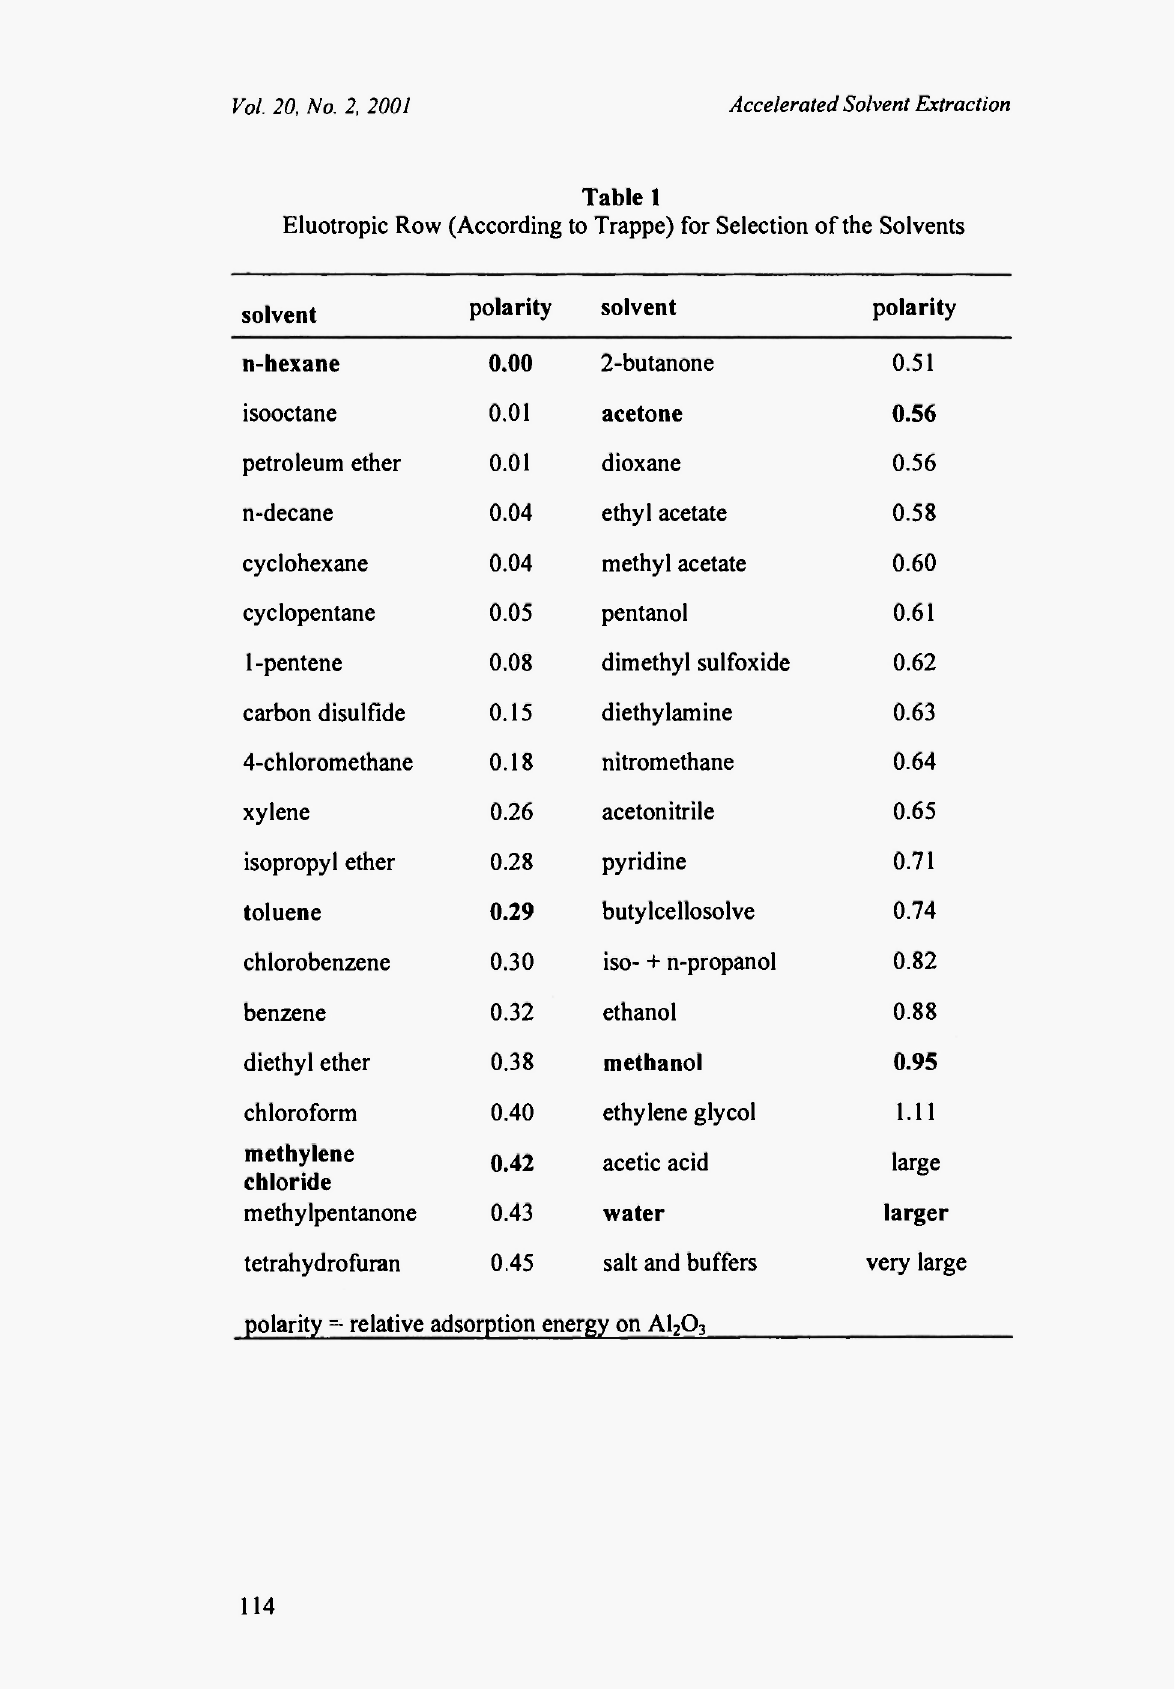
Eluotropic Row (According to Trappe) for Selection of the